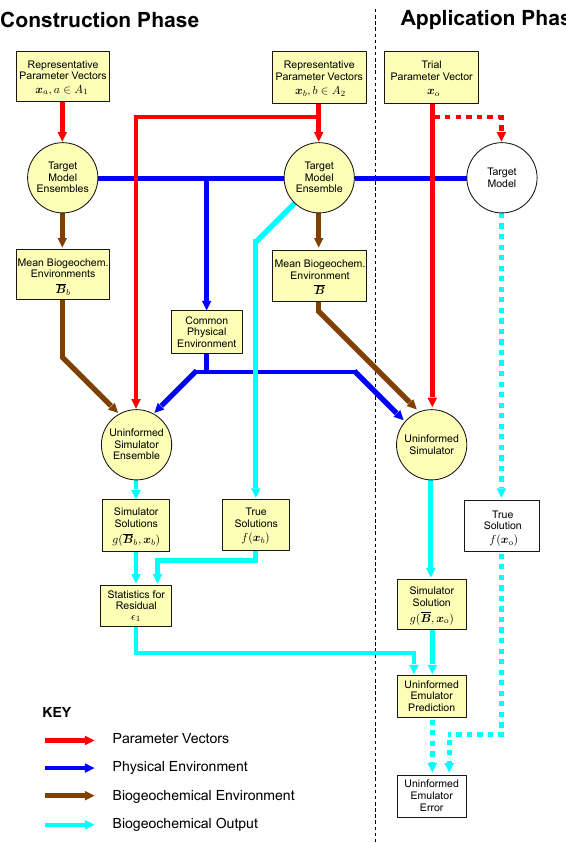
Figure 1. Data flow for emulator construction and application to the prediction of target model output where simulator uncertainty is quantified by the direct method. A 1 and A 2 are arbitrary sets of indices satisfying A 1 ∩ A 2 = ∅ . Simulation steps are indicated by circles. The dotted lines and uncoloured boxes indicate data flow for validating emulator performance against a known truth. They are not part of the practical application procedure, where the truth would be